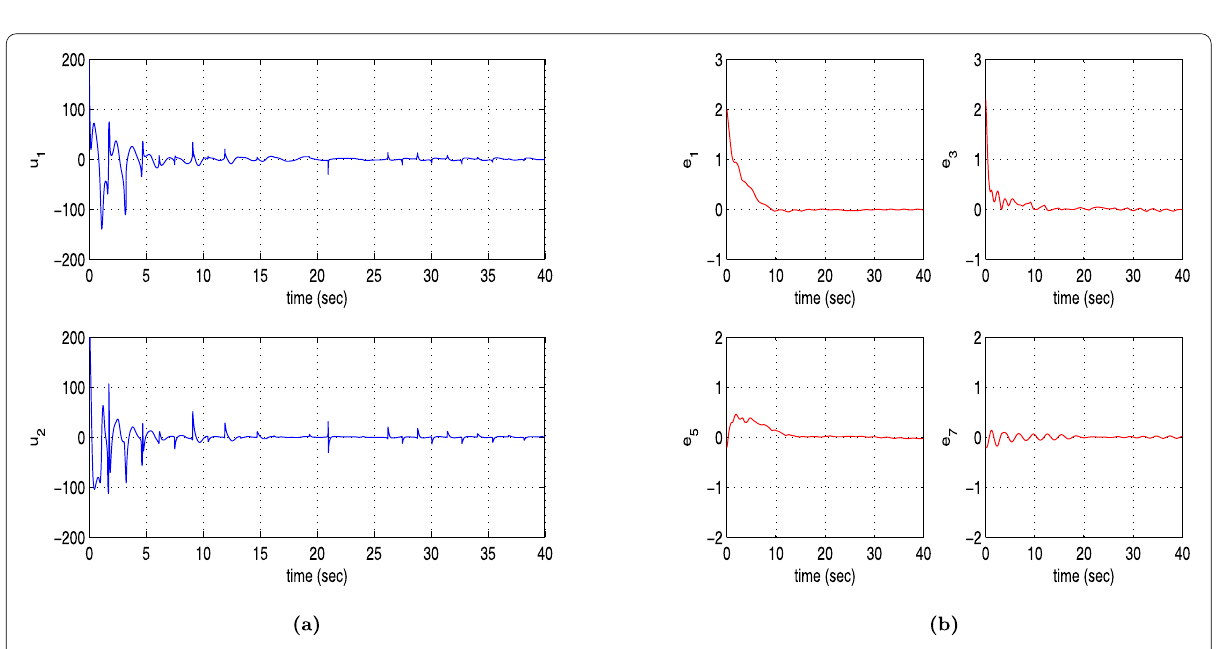
the tower crane’s dynamics (change (cid:7) a % in the mass M of by the H-infinity Kalman Filter, (iv) Table 4 which provides the approximate convergence times of the tower crane’s state variables to the associated